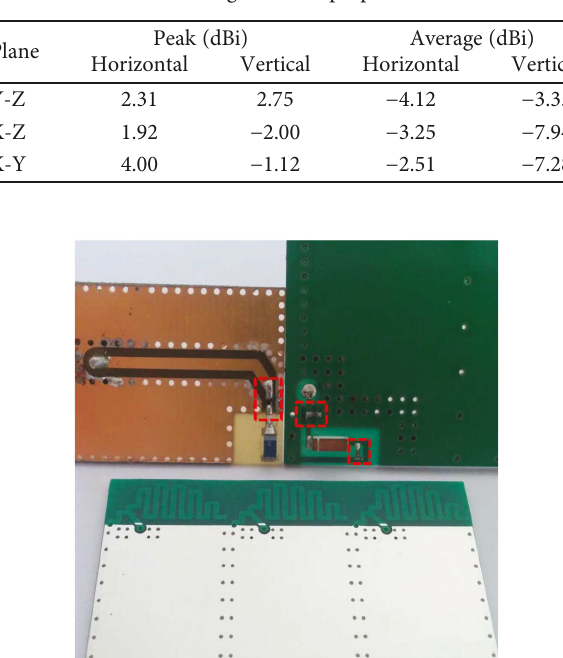
Table 2: The gain of the proposed PIFA.